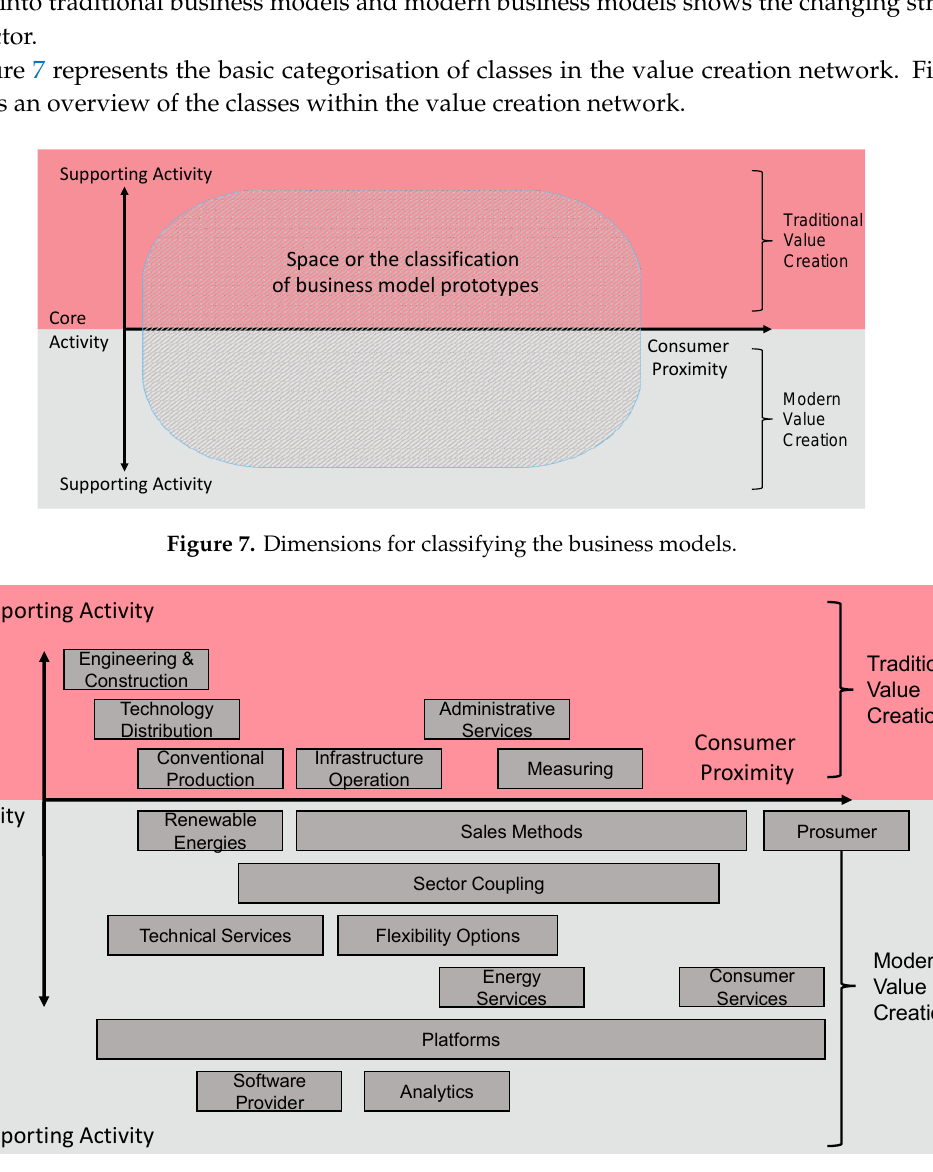
Figure 8. Overview of the business model